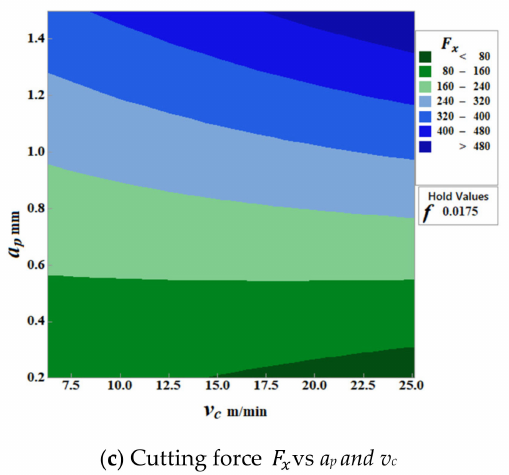
Figure 5. ( a – c ) Cutting force F x vs. v c , f , a p .